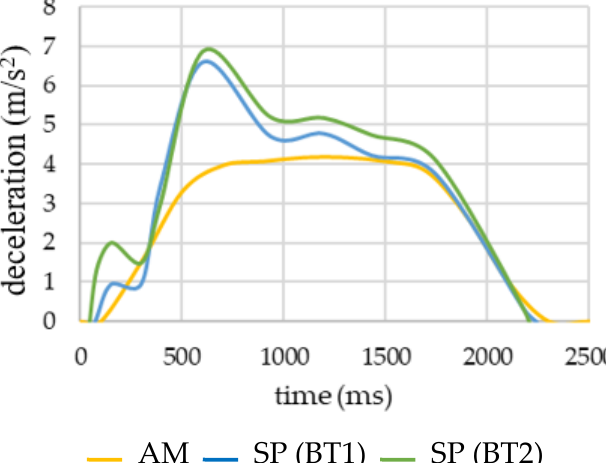
Figure 7. Average acceleration registered by the AM (accelerometer) and SP (smartphone) in the experiment. The deceleration results are absolute values.